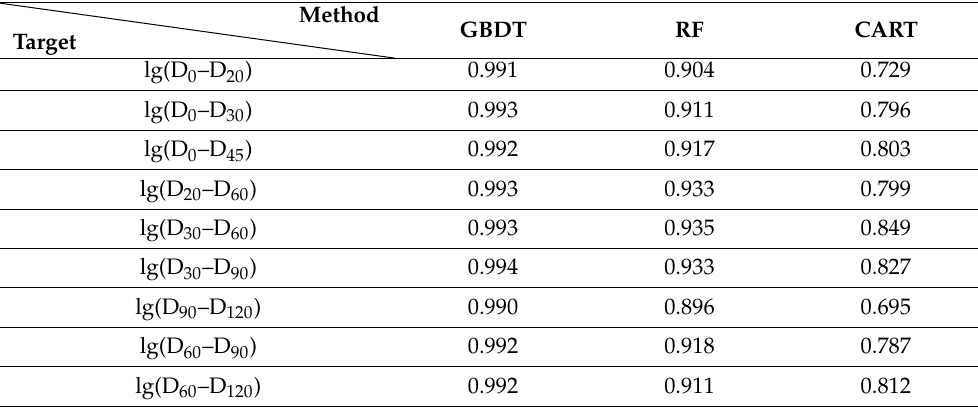
Table 3. R-square of three machine learning